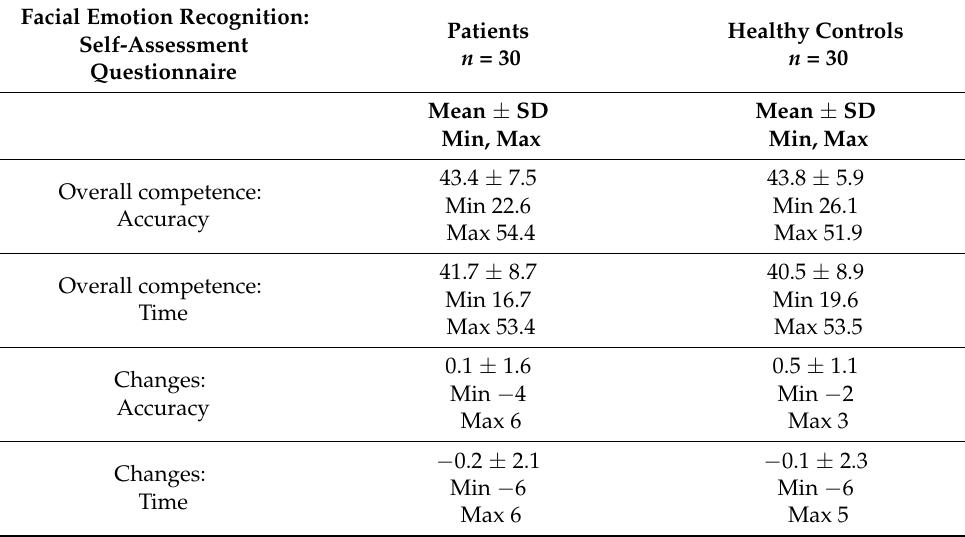
Table 5. Results of self-assessed facial emotion recognition (accuracy and time). Facial Emotion